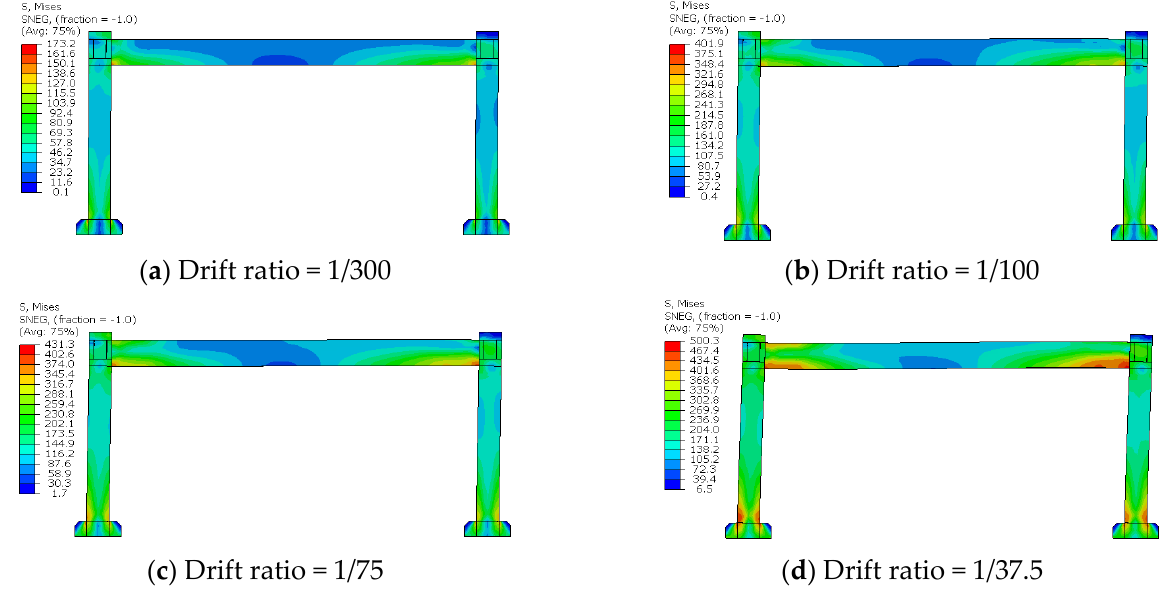
Figure 8. Stress cloud of the steel frame of specimen 1. Figure 9 depicts the stress cloud diagram of specimen 2 at a typical drift ratio. When